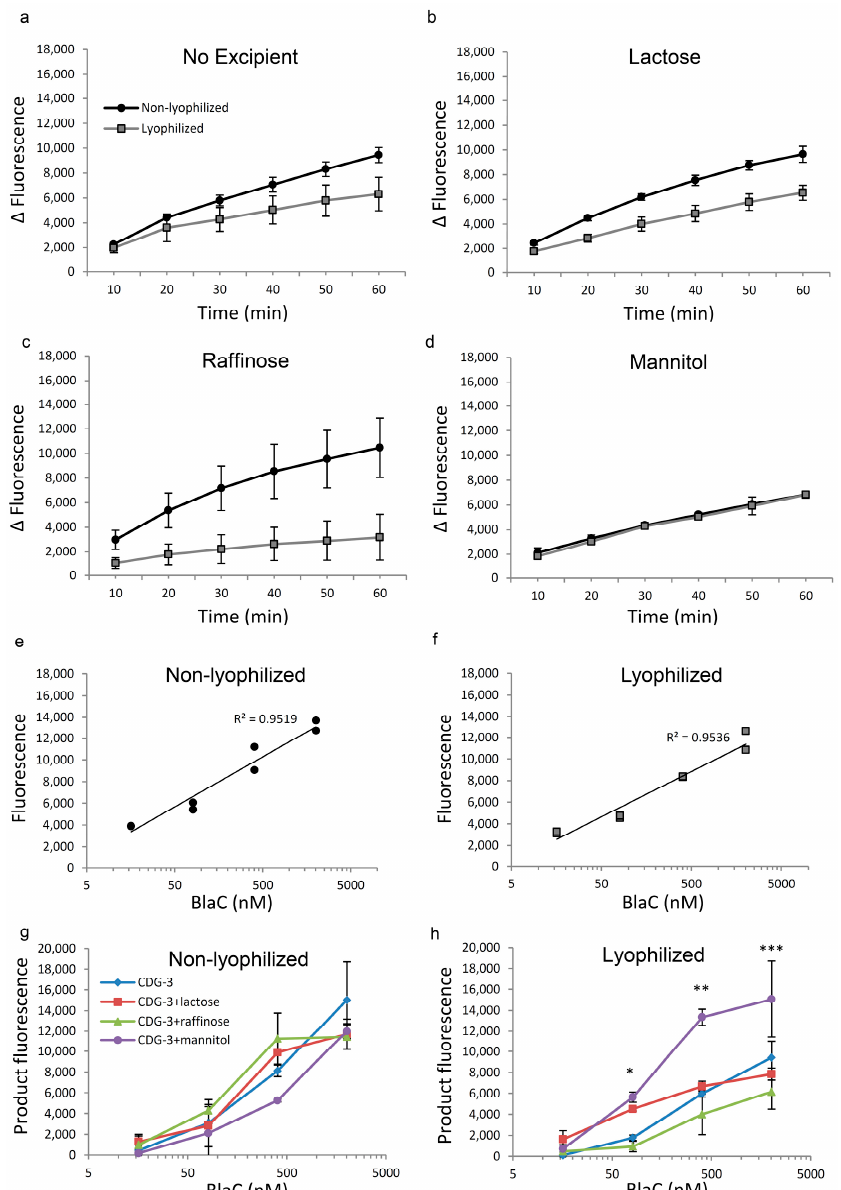
Figure 1. Excipients help stabilize the lyophilized CDG-3. Reaction of BlaC with non-lyophilized vs. lyophilized and reconstituted CDG-3 substrate without exposure to higher temperatures Fluorescence was used to compare the reaction rate of CDG-3 with BlaC in lyophilized vs. non-lyophilized samples (two experimental replicates per condition). ( a )—Kinetics of the reaction of purified 404 nM BlaC and CDG-3 substrate without excipients; ( b )—in the presence of lactose; ( c )—in the presence of raffinose; ( d )—in the presence of mannitol; ( e )—Relationships of BlaC concentration with fluorescence in non-lyophilized and ( f )—in lyophilized samples; ( g )—Changes in fluorescence within 30 min of incubation with and without excipients in non-lyophilized and ( h )—lyophilized samples. BlaC concentrations: 2022 nM, 404 nm, 81 nM and 16 nM. Error bars represent standard deviation. * p < 0.01 in the comparison between: CDG-3 and lactose, CDG-3 and mannitol, lactose and raffinose, lactose and mannitol; ** p < 0.01 in the comparison between: CDG-3 and mannitol, raffinose and mannitol, p < 0.05 in the comparison between lactose and mannitol; *** p < 0.05 between raffinose and mannitol.